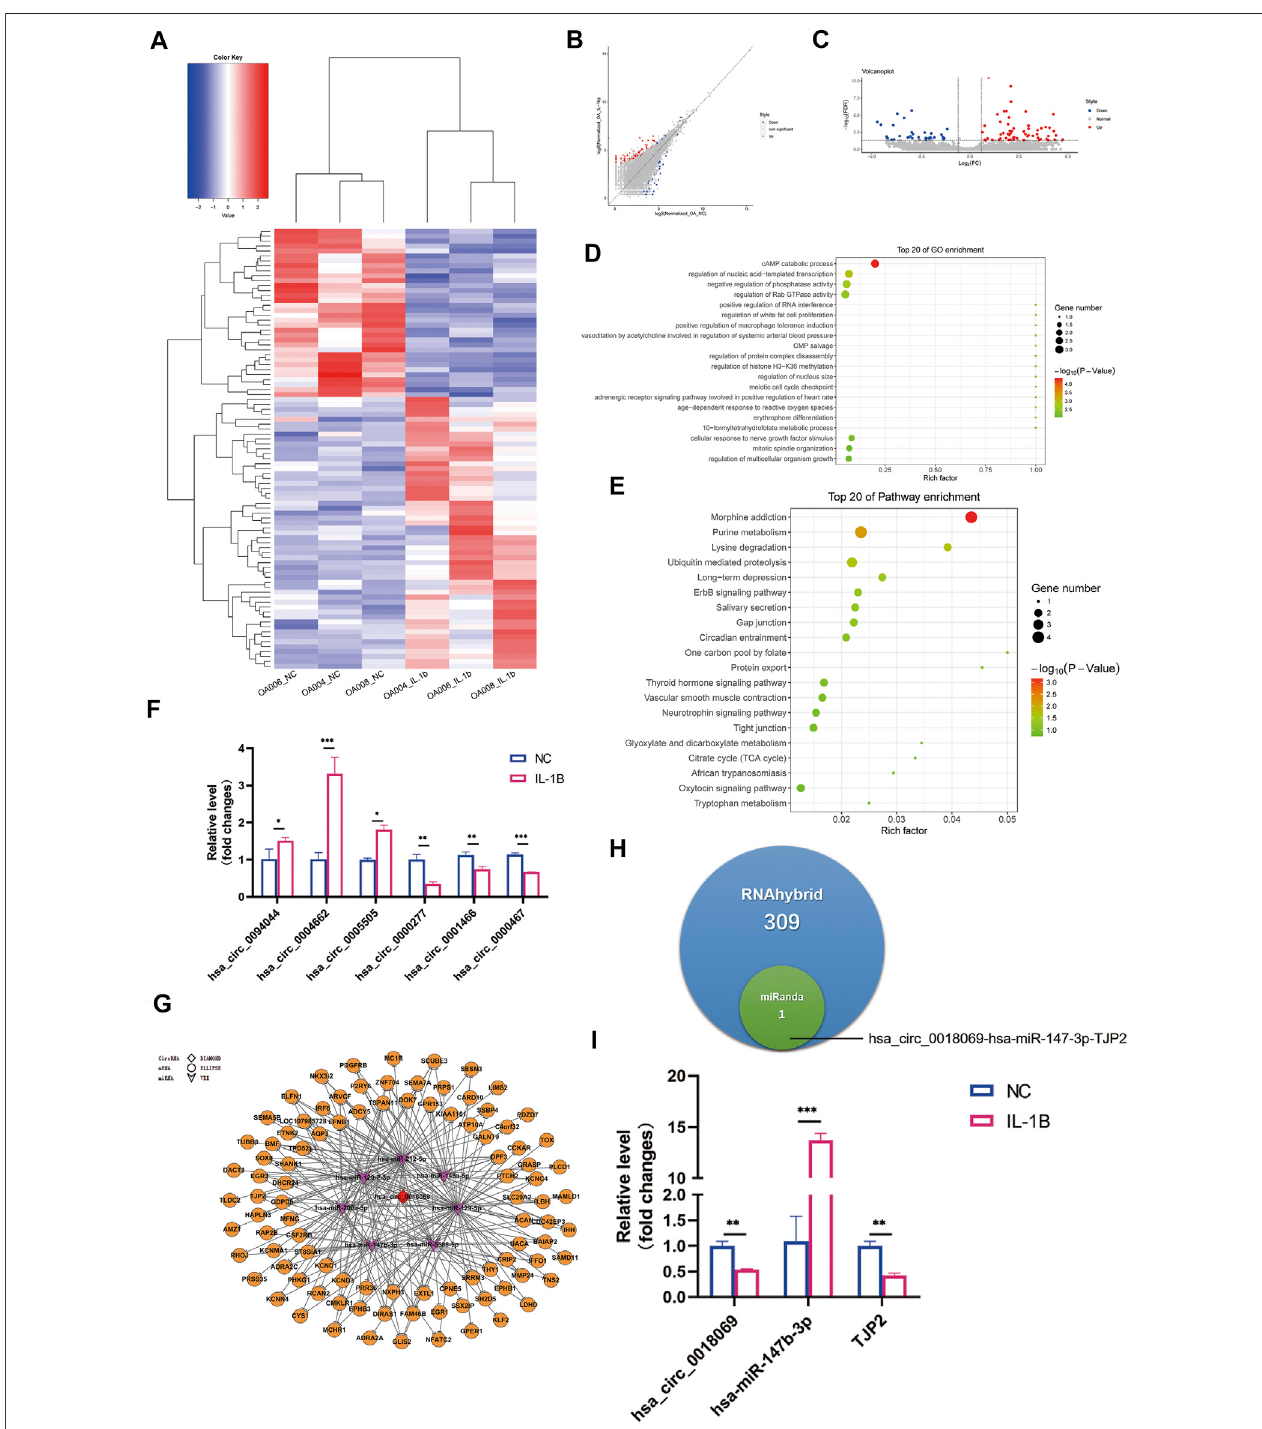
FIGURE 4 | Differential expression pro fi le of circular RNA (circRNA) and potential ceRNA prediction. (A) Hierarchical clustering illustrates distinguished expression differenceofcircRNAbetweenthetwogroupsandhomogeneitybetweengroups. (B) VolcanoplotsofdifferentiallyexpressedcircRNAs. (C) Scatterplotsofdifferentially expressedcircRNAs. (D) The20mostenrichedGeneOntology(GO)termsfortheparentalgenesofdifferentiallyexpressedcircRNAindegenerativemeniscitreatedwith IL-1 β . (E) The 20 most enriched pathway terms for the parental genes of differentially expressed mRNA in degenerative menisci treated with IL-1 β . (F) Relative expressionlevelsofselectedcircRNAsinnegativecontrolversusIL-1 β -treatedosteoarthritis(OA)menisci.GAPDHwasusedastheinternalreferencegeneforqRT-PCR relative expression. Error bars reveal the standard deviation or the standard error of the data. The statistical methods are described above. * p < 0.05, ** p < 0.01, *** p <